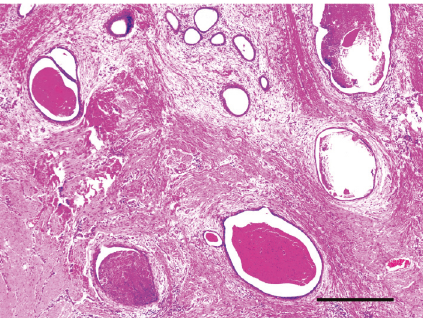
Figure 4: Pathologic observations. Endometrial tissue, hemosid- erin, phagocytic histiocytes, and granulation tissue are observed. Bar � 500 μ